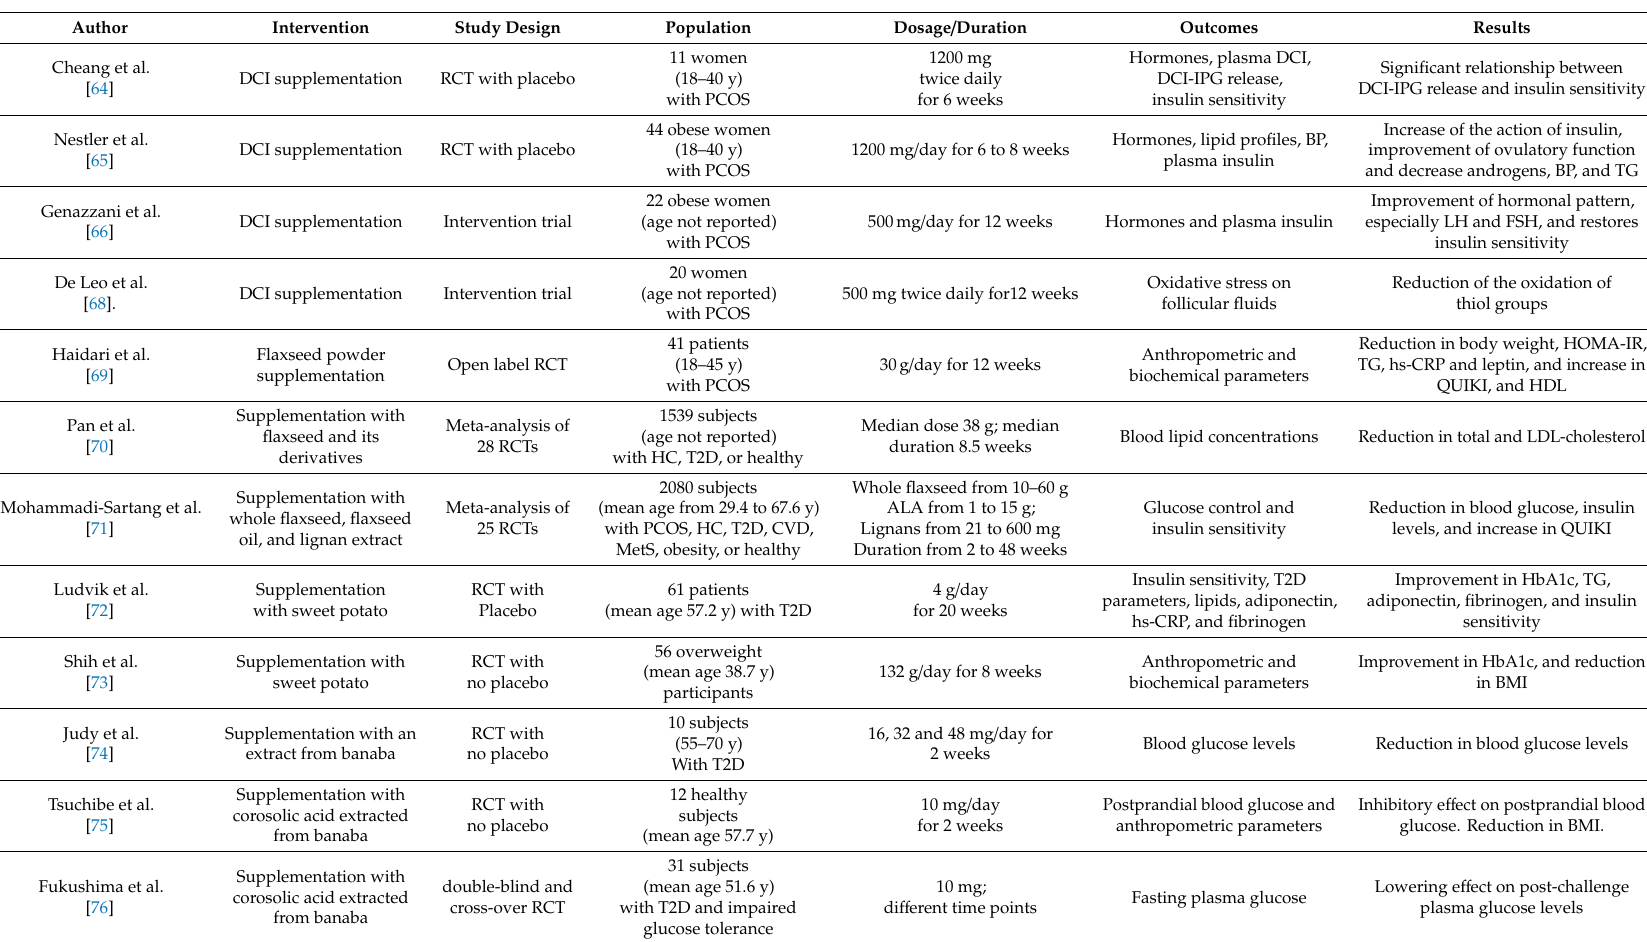
Table 1. Summary of the cited clinical studies and meta-analyses involving the use of d-chiro-inositol, flaxseed, sweet potato, and